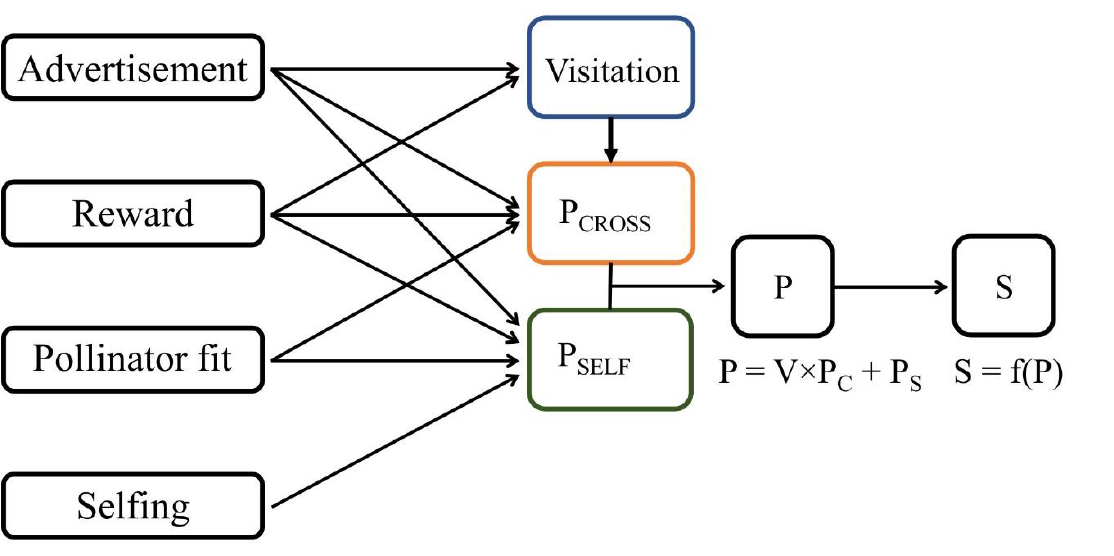
Figure 1. Graphical representation of a path-analytical fitness function linking pollination traits to female reproductive performance (predicted number of seeds produced, S ). The number of seeds produced is an asymptotic function of the number of pollen grains ( P ) deposited onto stigmas through cross- ( P CROSS ) and self-pollination ( P SELF ). Cross-pollen arrival is conditional on pollinator visitation. Pollen load can increase through attraction of pollinators responding to advertisement or reward traits, and the efficiency of pollen transfer is determined by the mechanical fit of the pollinator to the flower. The rate of self- pollination is also determined by traits affecting within-flower pollen transfer. This approach isolates the process of pollination from other sources of variation in fitness by defining seed set as a direct function of pollen deposition. Selection gradients can be obtained by regressing the predicted relative fitness values on the